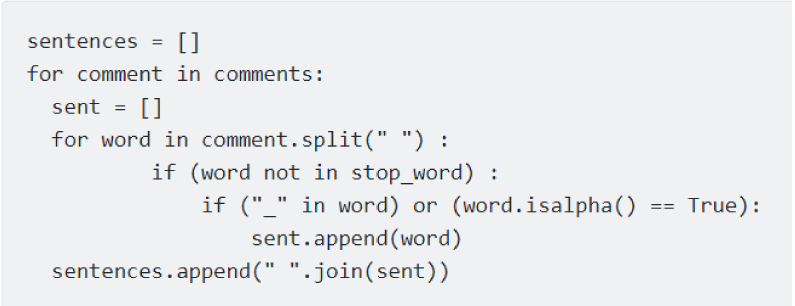
Figure 5. Command Remove stop word.